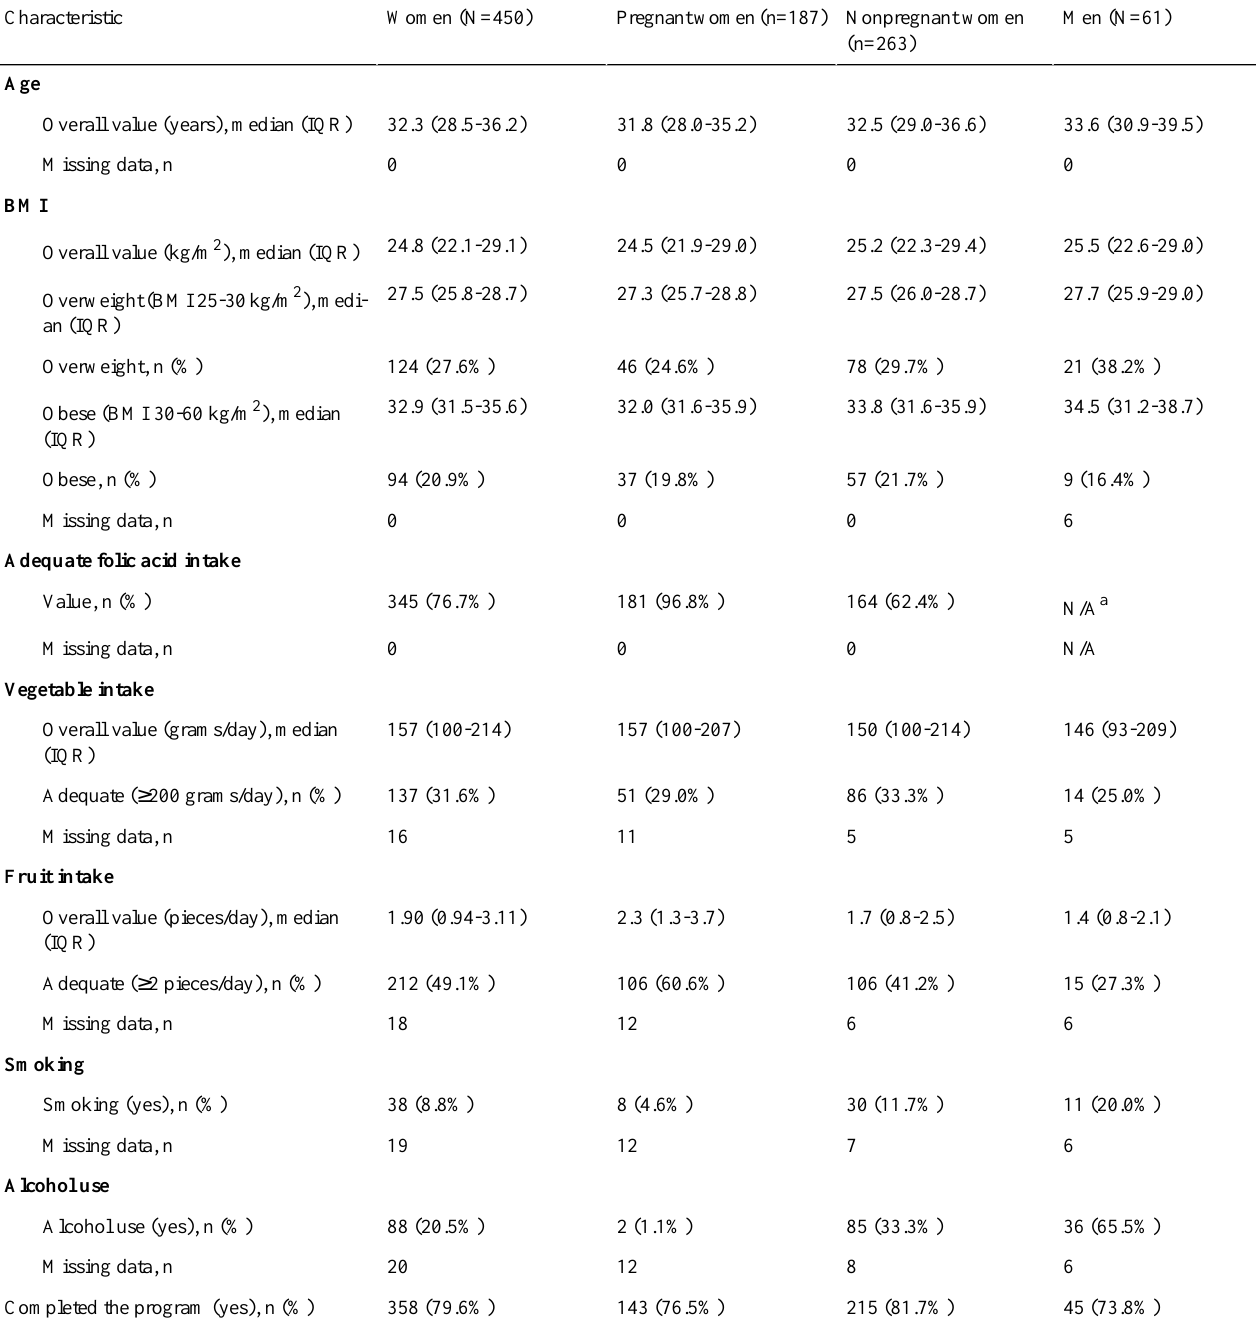
Table 1. Baseline characteristics of the study participants stratified by sex and pregnancy